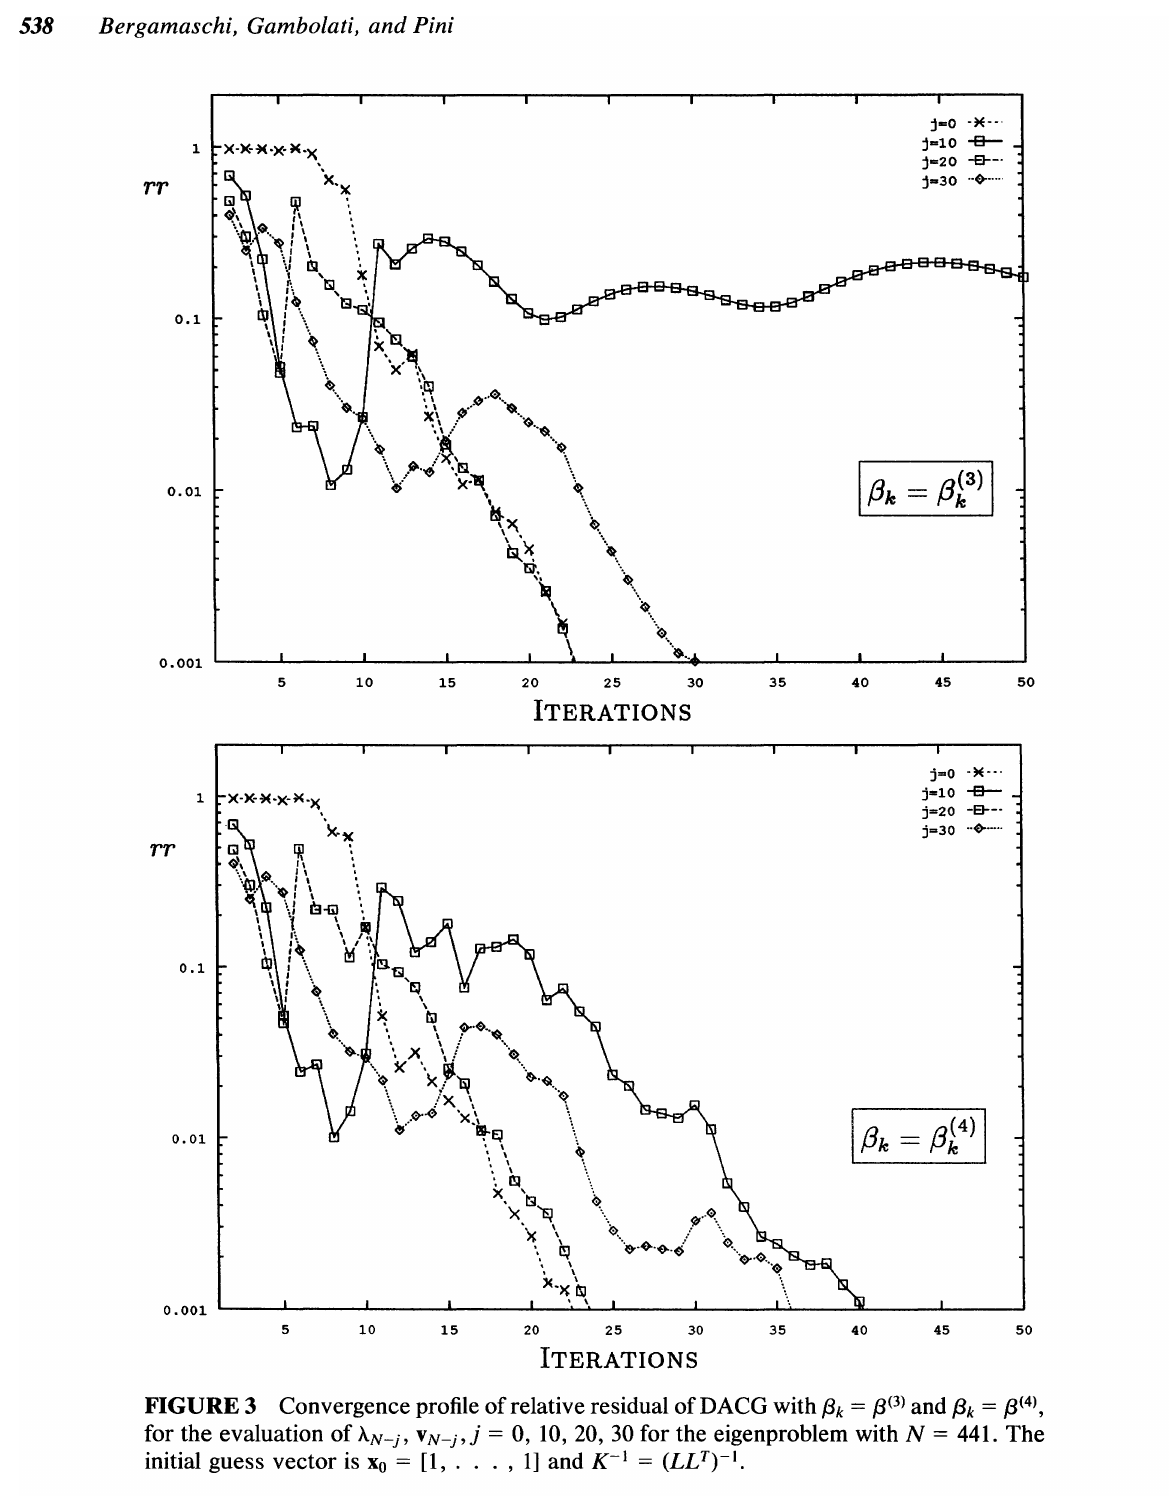
FIGURE 3 Convergence profile of relative residual ofDACG with 13k = 13(3) and 13k = 13(4), for the evaluation of AN-j, VN-j,j = 0, 10,20,30 for the eigenproblem with N = 441. The initial guess vector is Xo = [1, ... , 1] and K-I =